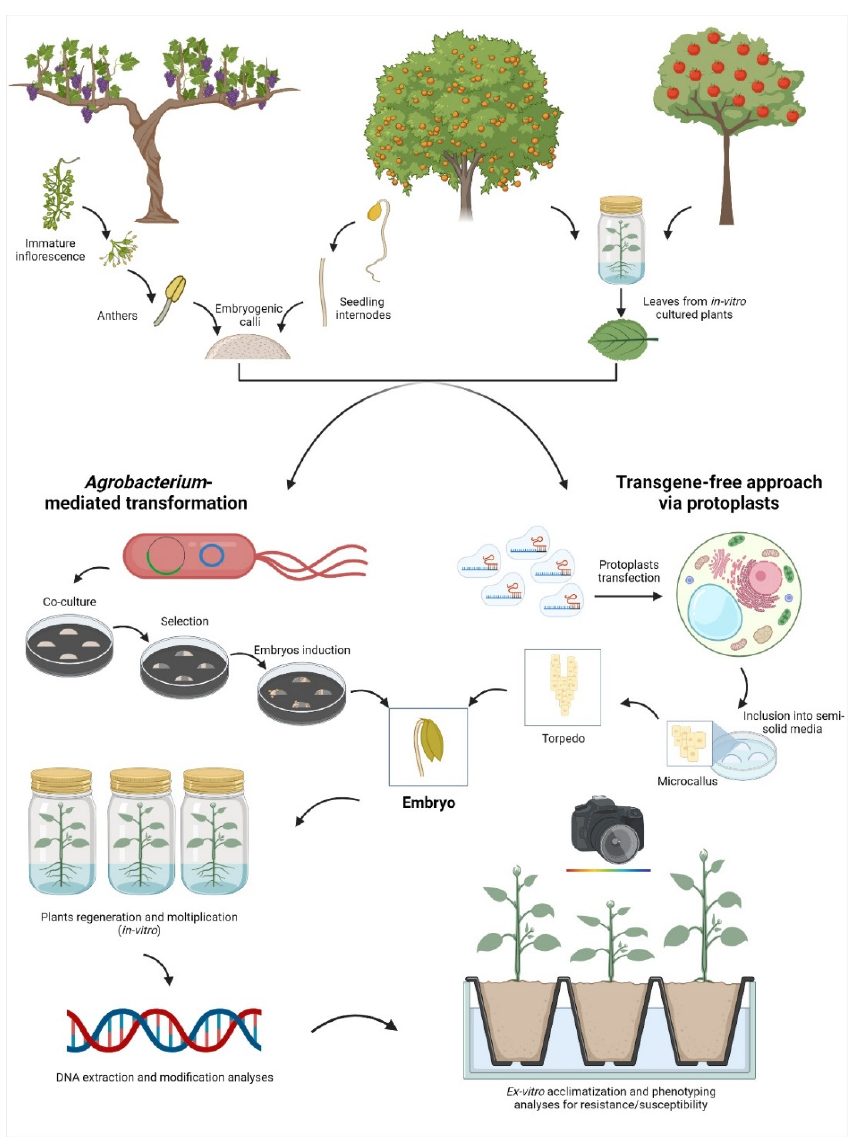
Figure 2. Representation of the main workflows exploited for the application of the new genomic techniques (NGTs) in some fruit crops selected as an example using somatic embryos. From left to right: in grapevine, the most exploited tissues to produce embryogenic calli belong to flowers (e.g., anthers and ovaries); in Citrus , hypocotyls are exploited to obtain embryogenic calli; in apple, there is no need for embryogenic calli since, if cultured in specific conditions, the leaf cells are able to regenerate the entire plant via organogenesis. Once the morphogenic competent tissue is obtained, there are two main approaches to apply NGTs: the classical method through Agrobacterium - mediated transformation or the isolation and transfection of protoplasts (DNA-free approach). Once the transformation/transfection event is completed, embryos are regenerated, and the genetic and phenotypic analyses are then performed. For example, this issue is quite relevant in grapevine, where the most diffuse tissue type for transformation events and the only one available for totipotent protoplasts isolation and transfection is the embryogenic callus [63,64]. In grapevine, it can be obtained from floral tissues (e.g., anthers and ovaries) but the competency in producing embryogenic callus is genotype-specific, and many varieties are still recalcitrant [65]. Comparable, or even more challenging, is the case of peach where reports of genetically